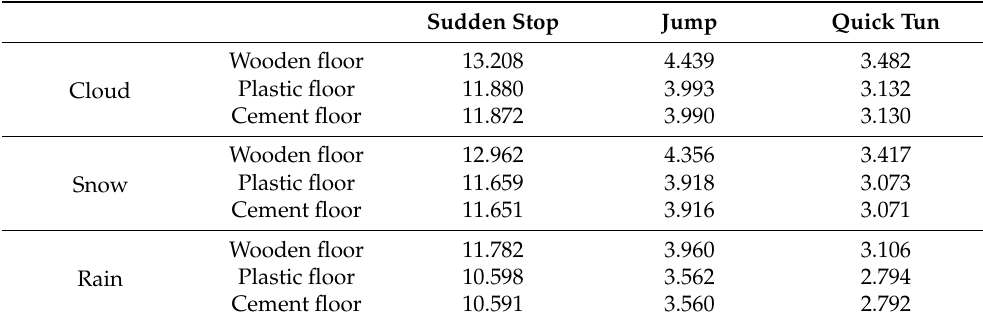
Table 8. Odd ratio (OR) value of combined risk factors (non-contact injury).